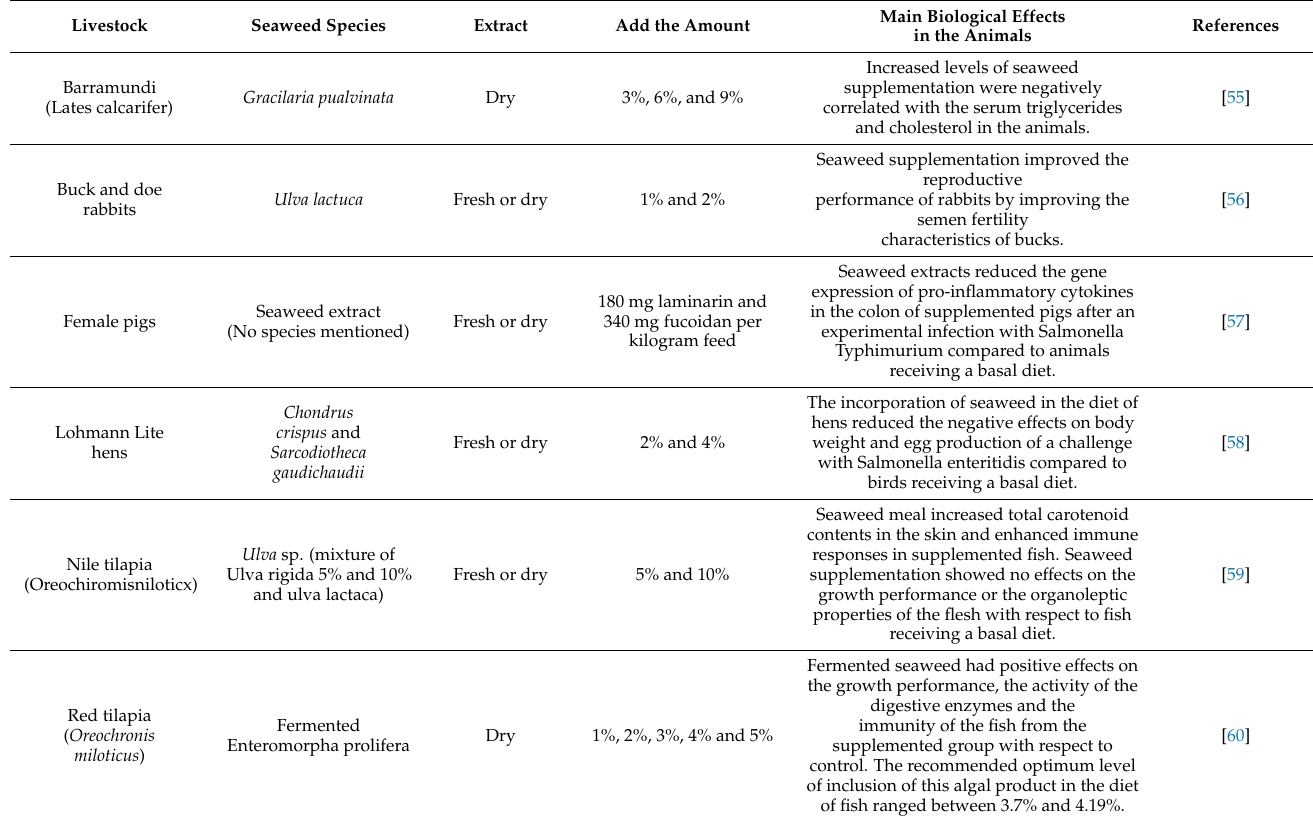
Table 2. Application of macroalgae in animal feeds and its effect on product quality.